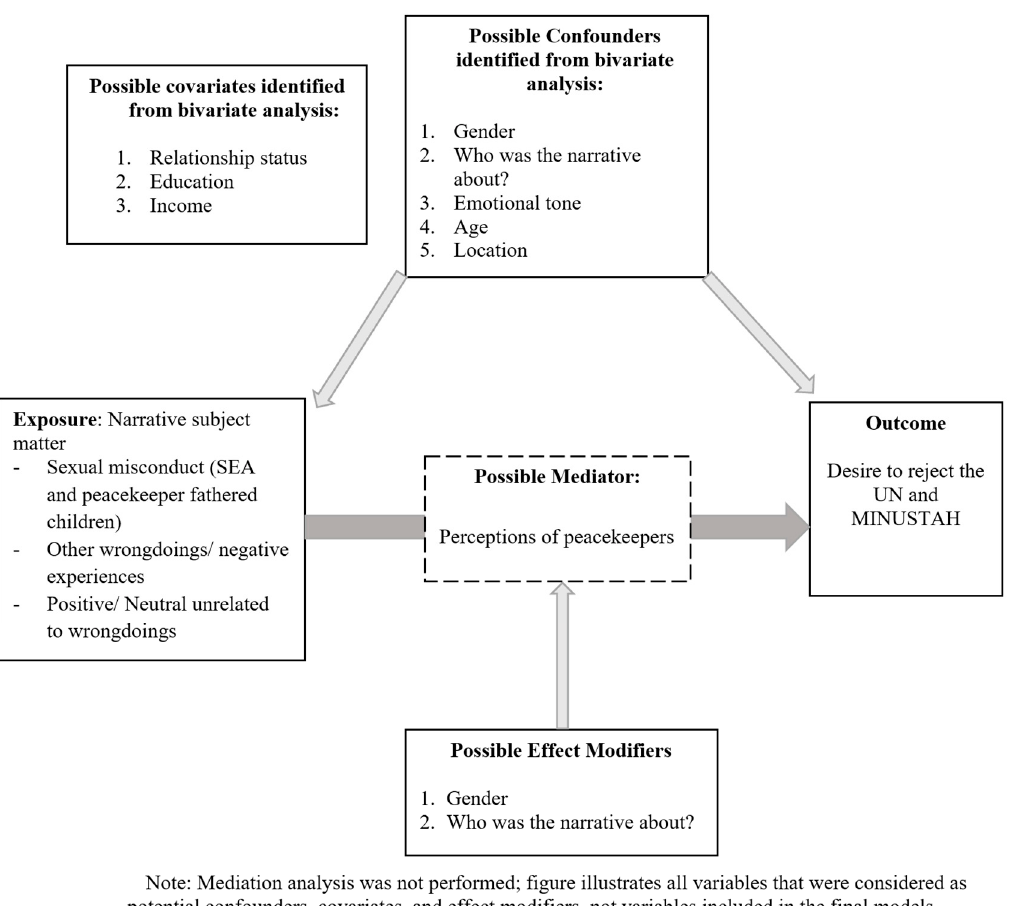
Figure 2. Conceptional Model for Objective 2.